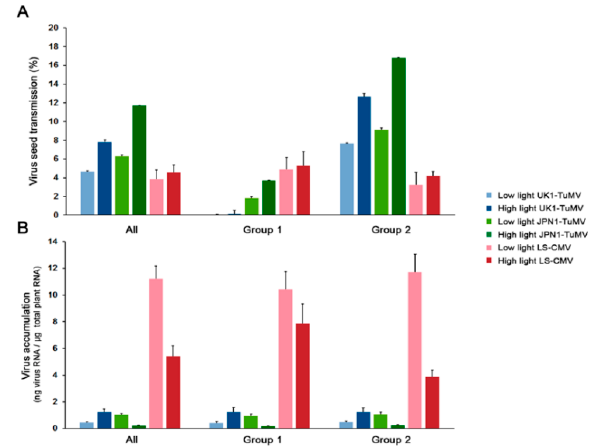
Figure 1. E ff ect of light intensity on: ( A ) The e ffi ciency of virus seed transmission and ( B ) on virus accumulation. Values are mean ± standard error of 18 (All), 7 (Group 1) and 11 (Group 2) Arabidopsis